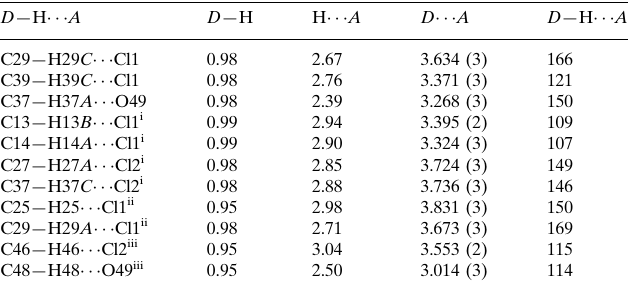
Hydrogen-bond geometry (A˚ , (cid:3)